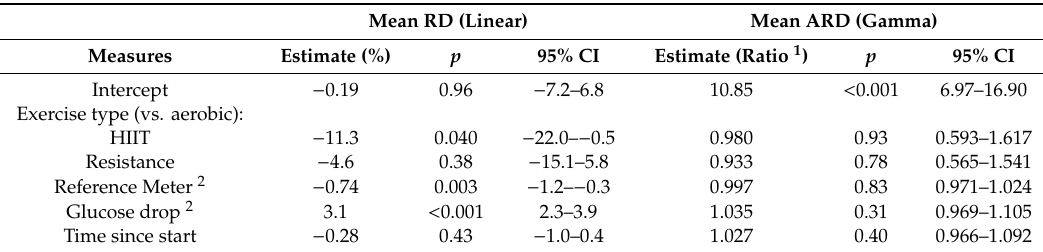
Table 2. Mixed-e ff ects linear and gamma regression model summaries for mean relative di ff erence (RD) and mean absolute relative di ff erence (ARD). Table 2. Mixed-effects linear and gamma regression model summaries for mean relative difference (RD) and mean absolute relative difference (ARD).